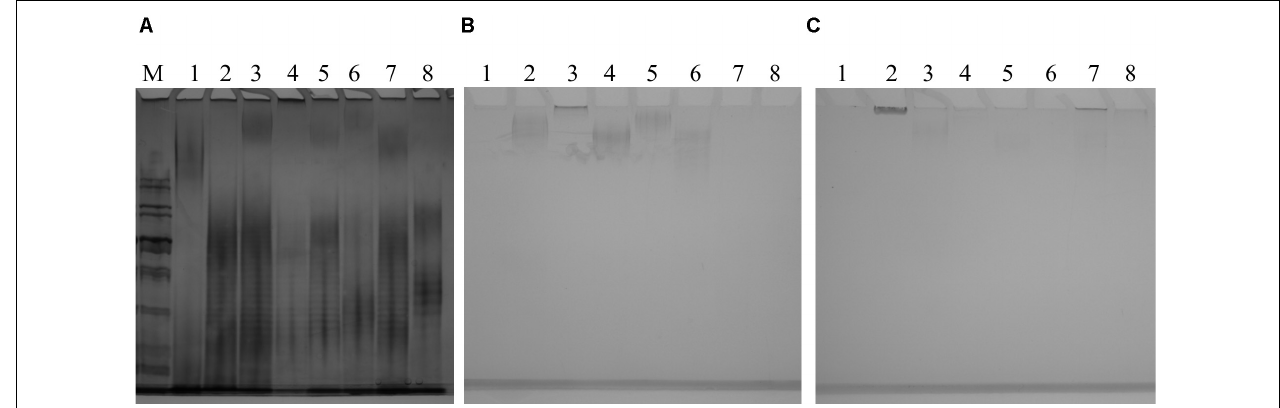
FIGURE 7 | (A) Silver-stained gel of lipopolysaccharide preparations from a panel of O89m E. coli isolates and reference strains. Strains examined are: NCTC9089 (O89 reference strain) – lane 1; 26561/G246 – lane 2; C720825/G315 – lane 3; C021088_1/G189 – lane 4; C447731/G324 – lane 5; 2308/G76 – lane 6; C232039_2/G310 – lane 7; NCTC11107 (O9 reference strain) – lane 8. With the exception of NCTC9089, strains showed a clear ladder pattern which was almost indistinguishable among O89m strains and distinct from both reference O89 and O9 strains. Alcian blue-stained gels of cell-associated (B) and extracellular (C) polysaccharides from a panel of O89m E. coli isolates and reference strains. Strains are: NCTC9089 (O89 reference strain) – lane 1; 26561/G246 – lane 2; C720825/G315 – lane 3; C021088_1/G189 – lane 4; C447731/G324 – lane 5; 2308/G76 – lane 6; C232039_2/G310 – lane 7; NCTC11107 (O9 reference strain) – lane 8. With the exception of NCTC9089, all other strains possess group 1 capsule loci and demonstrate staining of high molecular weight material in cell-associated and extracellular